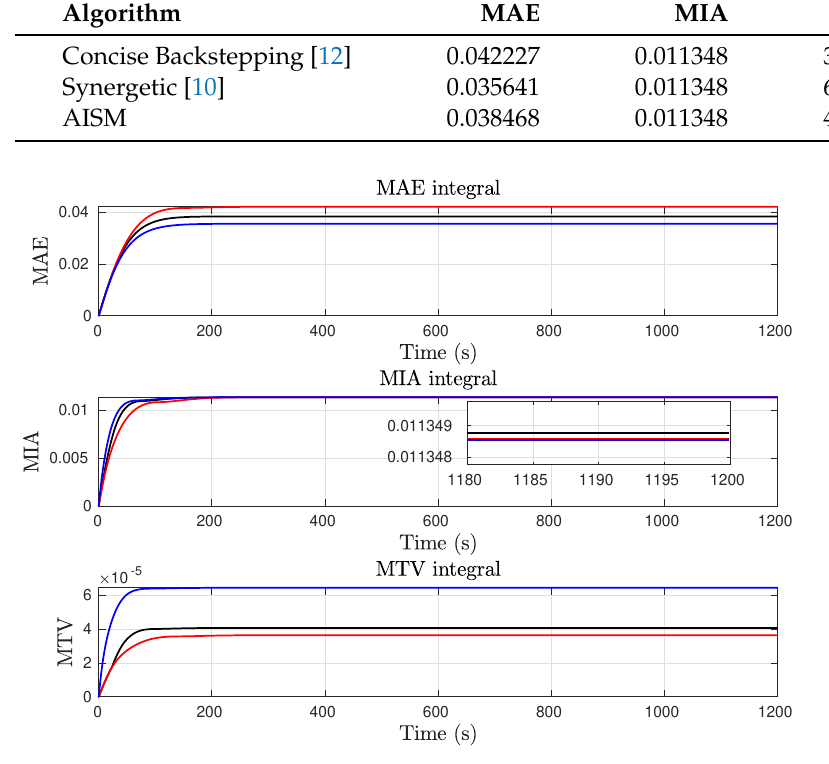
Figure 4. Constant yaw reference test with d ( t ) = 0. Performance indices evolution. Cyan line: Reference; Red line: Concise backstepping (Zhang et al.); Blue line: Synergetic (Muhammad et al.); Black line: Adaptive sliding mode (González-Prieto et